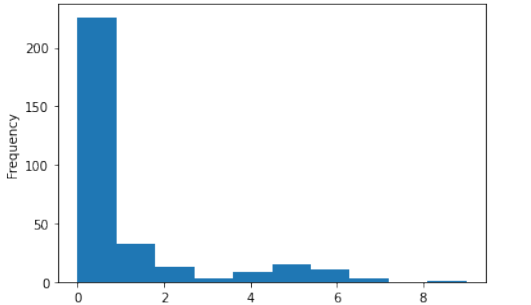
Figure 4. Distribution of time differences between satellite image and in situ measurement expressed in